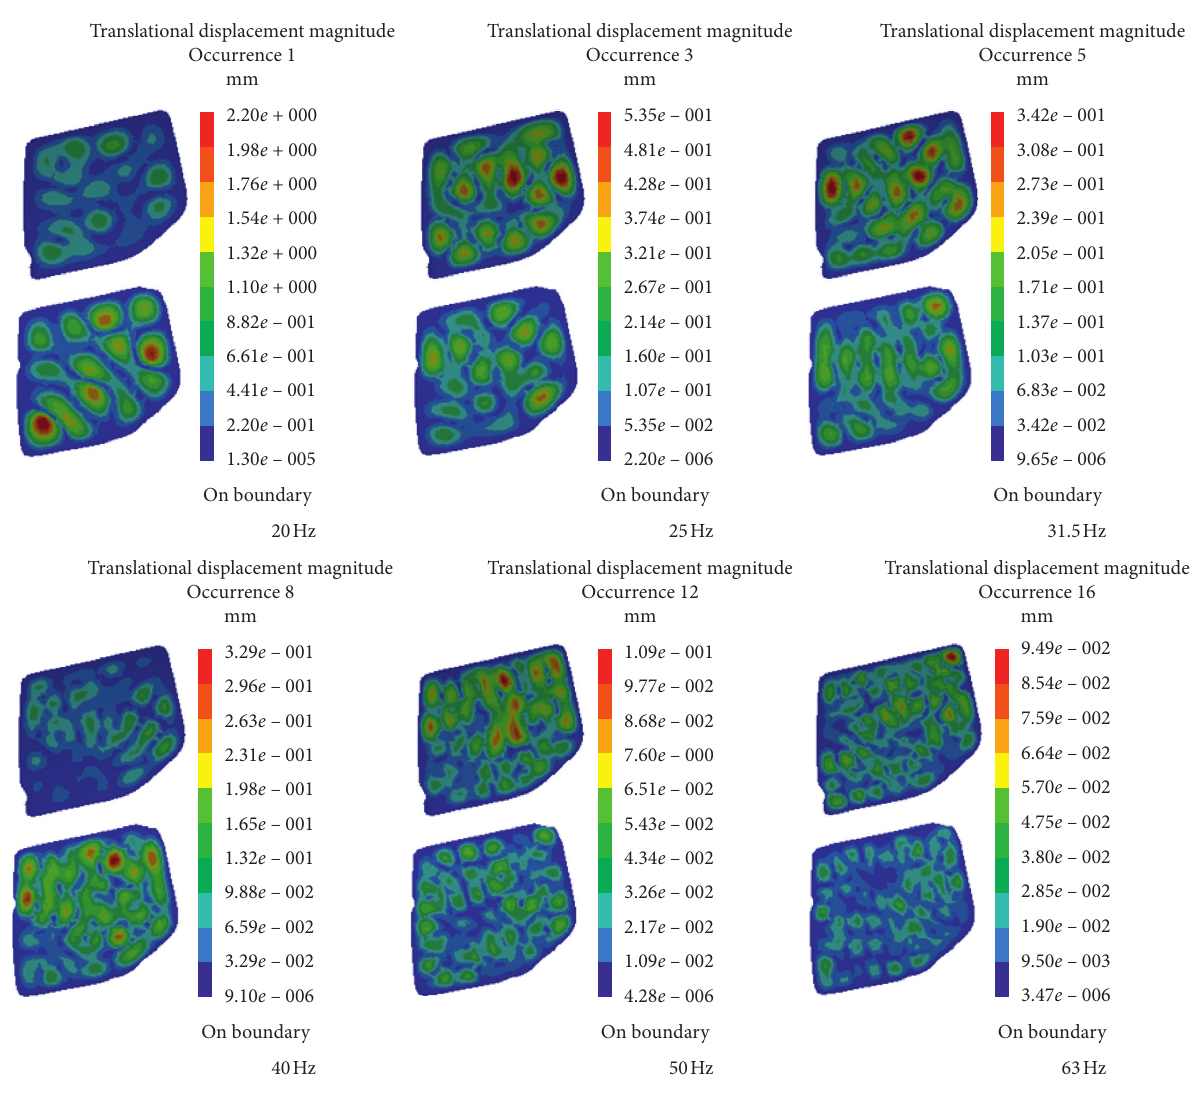
Figure 8: Responses of the two side windows of the fluctuating